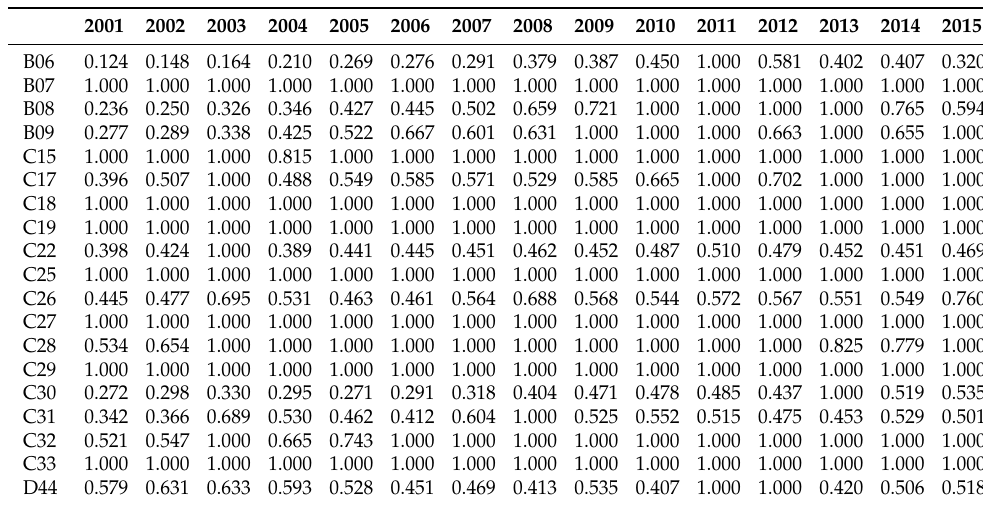
Table 3. 2005–2015 Environmental efficiency of various heavy pollution sub-industries in